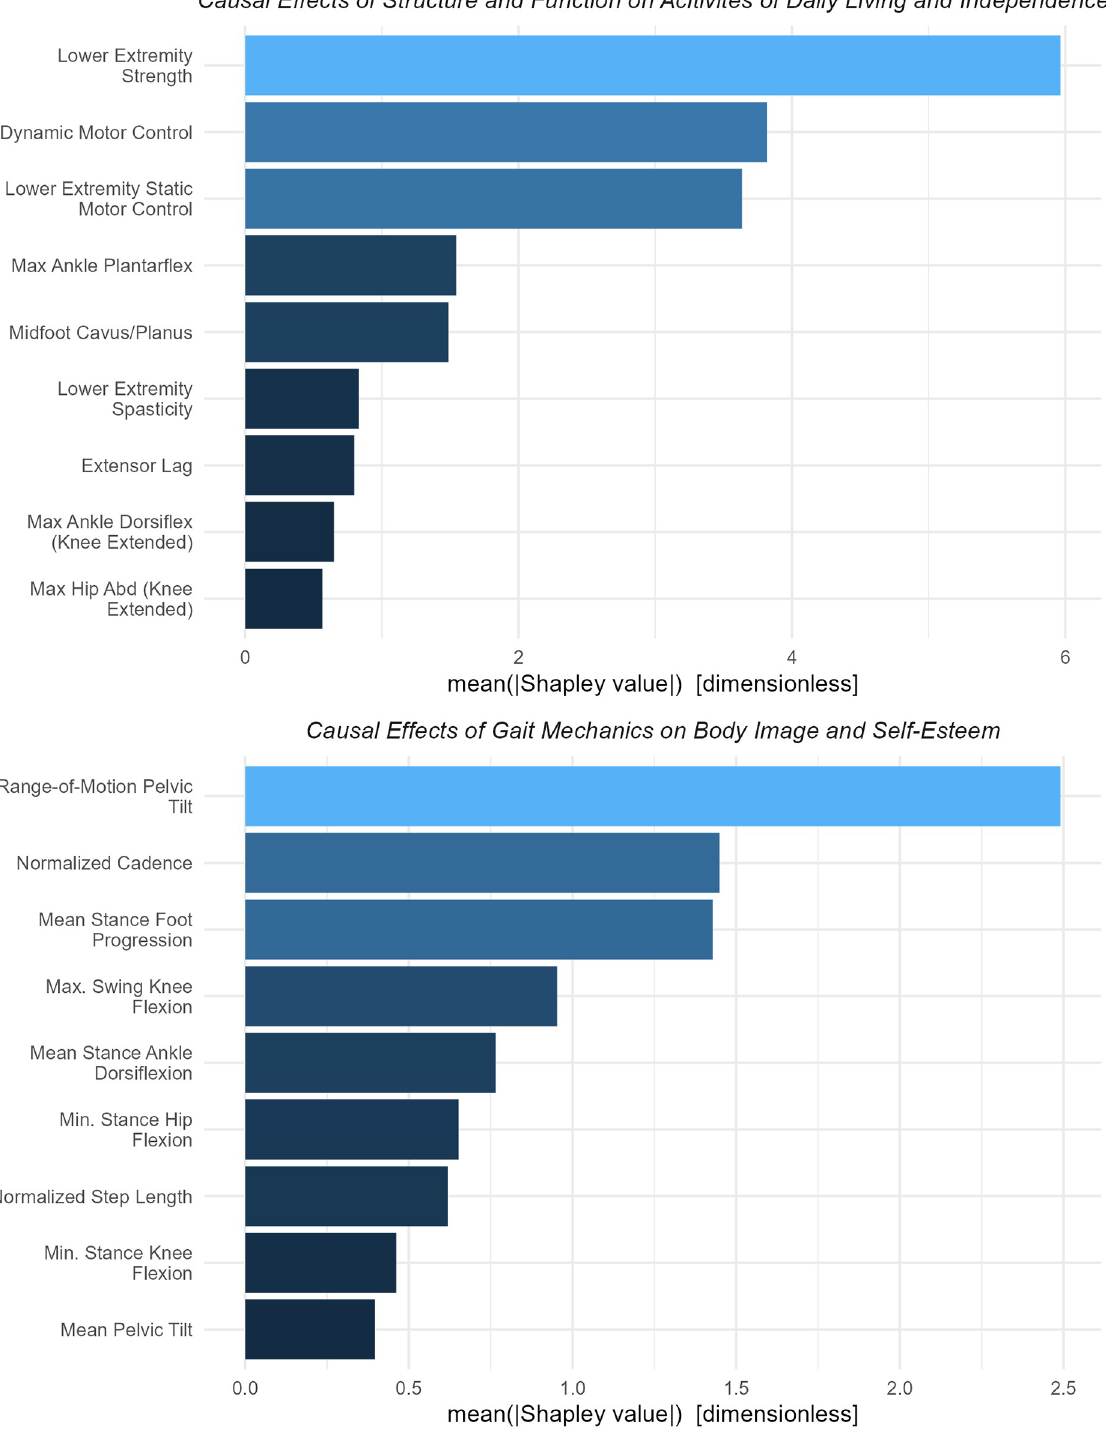
Fig 13. Importance of Structure and Function effects on Activities of Daily Living and Independence, Importance of Gait Mechanics effects on Body Image and Self-Esteem. Strength and motor control dominate causes of Activities of Daly Living and Independence. These factors are difficult to change using currently available treatments. Some of the important causal variables can be addressed with well- established treatments. For example, ankle plantarflexion (Activities of Daily Living and Independence) or mean stance foot progression (Body Image and